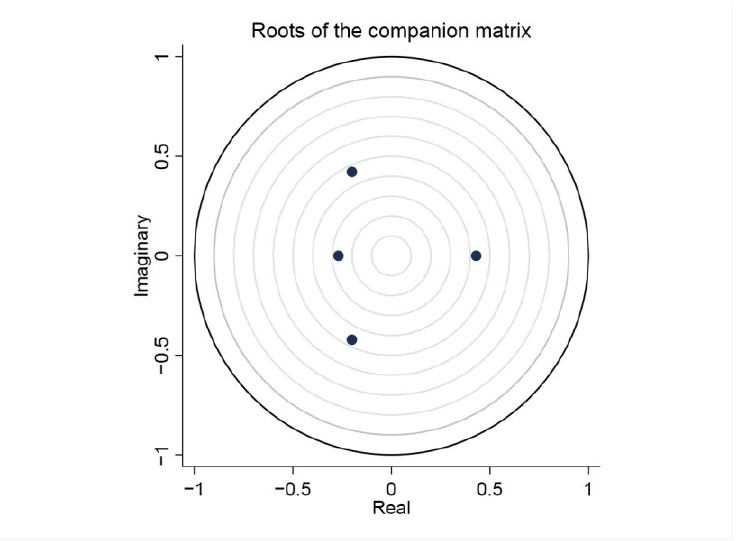
Figure 3. The results of stability test. The largest circle in the figure represents the unit circle.